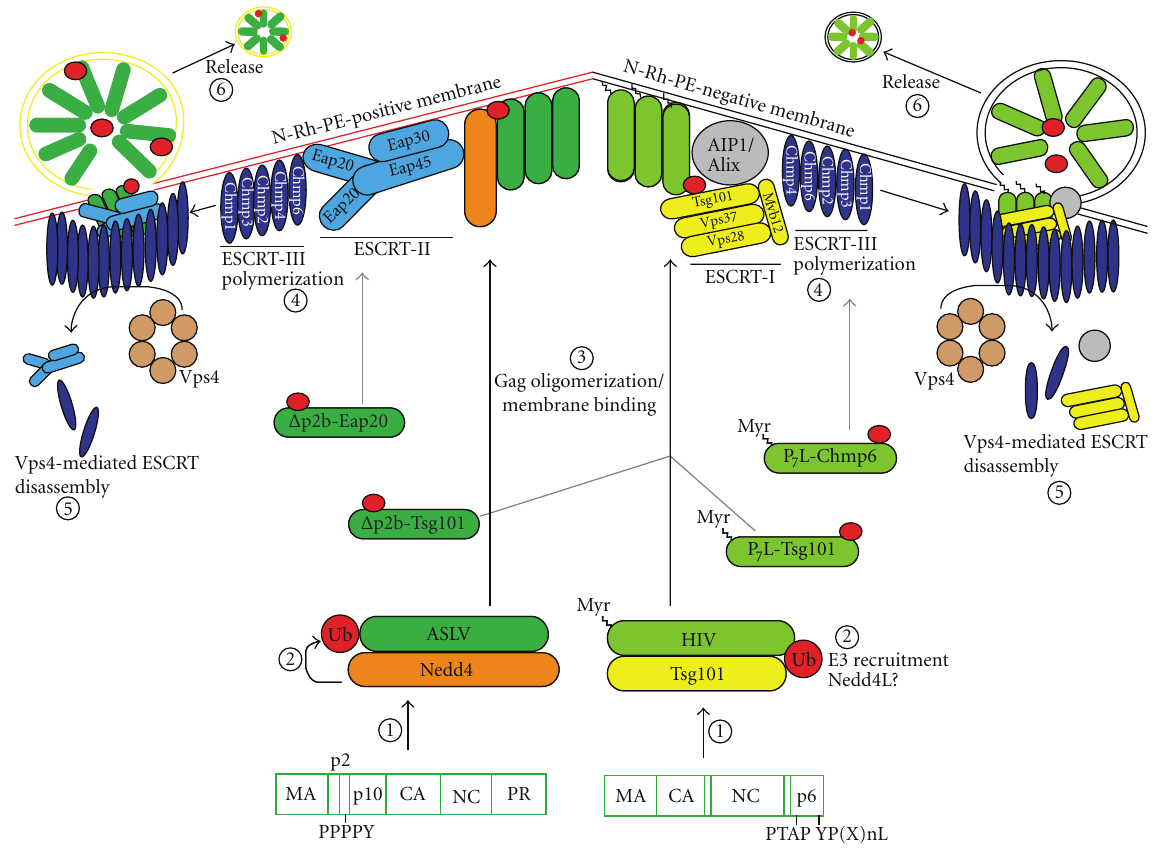
Figure 1: Parallel pathways in ASV and HIV-1 Gag budding. Retroviruses recruit components of the ESCRT machinery to build a budding complex for particle release. (1) The dominant L domains for HIV-1 and ASV Gag bind to Tsg101 and Nedd4, respectively. Whether this initial interaction takes place in the cytosol or at the plasma membrane remains to be defined. (2) Nedd4 mediates ubiquitination of ASV Gag. HIV-1 Gag is ubiquitinated by an unidentified E3 ligase. Some evidence suggests that Nedd4L may play a role since its overexpression rescues budding of HIV-1 Gag/ Δ PTAP. (3) Gag oligomerization in the cytosol increases membrane avidity and rapidly targets Gag to sites of assembly/budding on the plasma membrane. ASV Gag assembles on N-Rh-PE-positive, endosome-derived membranes. HIV-1 Gag assembles on N-Rh-PE-negative membranes. (4) During the budding process, Gag may recruit additional ESCRT factors eventually leading to ESCRT-III polymerization at the base of a budding particle. (5) ESCRT-III subunits recruit the AAA ATPase, Vps4, to mediate the disassembly of membrane-bound ESCRT complexes and to provide the energy for membrane fission. (6) VLPs are released from cellular membranes. Covalently linking ESCRT proteins to the C-terminus of Gag bearing L domain-mutations restores budding at di ff erent stages. Tethering Tsg101 to ASV Gag/ Δ p2b ( Δ p2b-Tsg101) or HIV-1 Gag/P7L (P7L-Tsg101) rescues budding through an HIV-like pathway (ESCRT-I-dependent, N-Rh-PE-negative membranes). Tethering EAP20 to ASLV Gag/ Δ p2b ( Δ p2b-Eap20) rescues budding through an ASLV-like pathway (ESCRT-II-dependent, N-Rh-PE-positive membranes). Black arrows indicate wild-type Gag budding pathways. Gray arrows indicate reconstituted budding pathways of ASLV Gag/ Δ p2b-ESCRT fusions and HIV-1 Gag/P7L-ESCRT